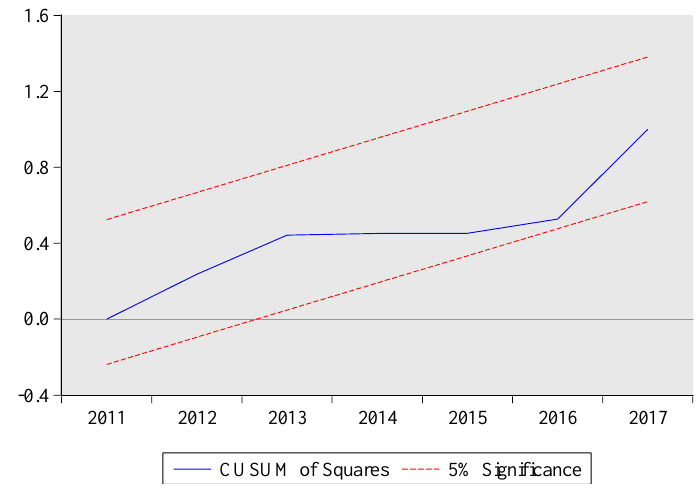
Figure 6. CUSUMSQ test for Model 2. The plot of the cumulative sum of squares of the recursive residuals. Note: The red dashed lines represent the critical bounds at the five percent significance level. Table 12. Long-run and short-run results of the ARDL method for Model